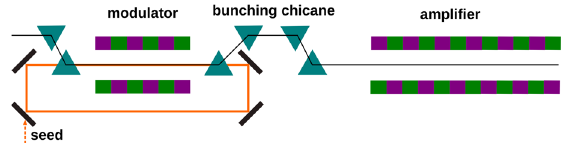
FIG. 1. Simplified schematic view of an HGHG seeded oscillator-amplifier. The orange line represents the path of the light pulse in the cavity and the black one the electron beam